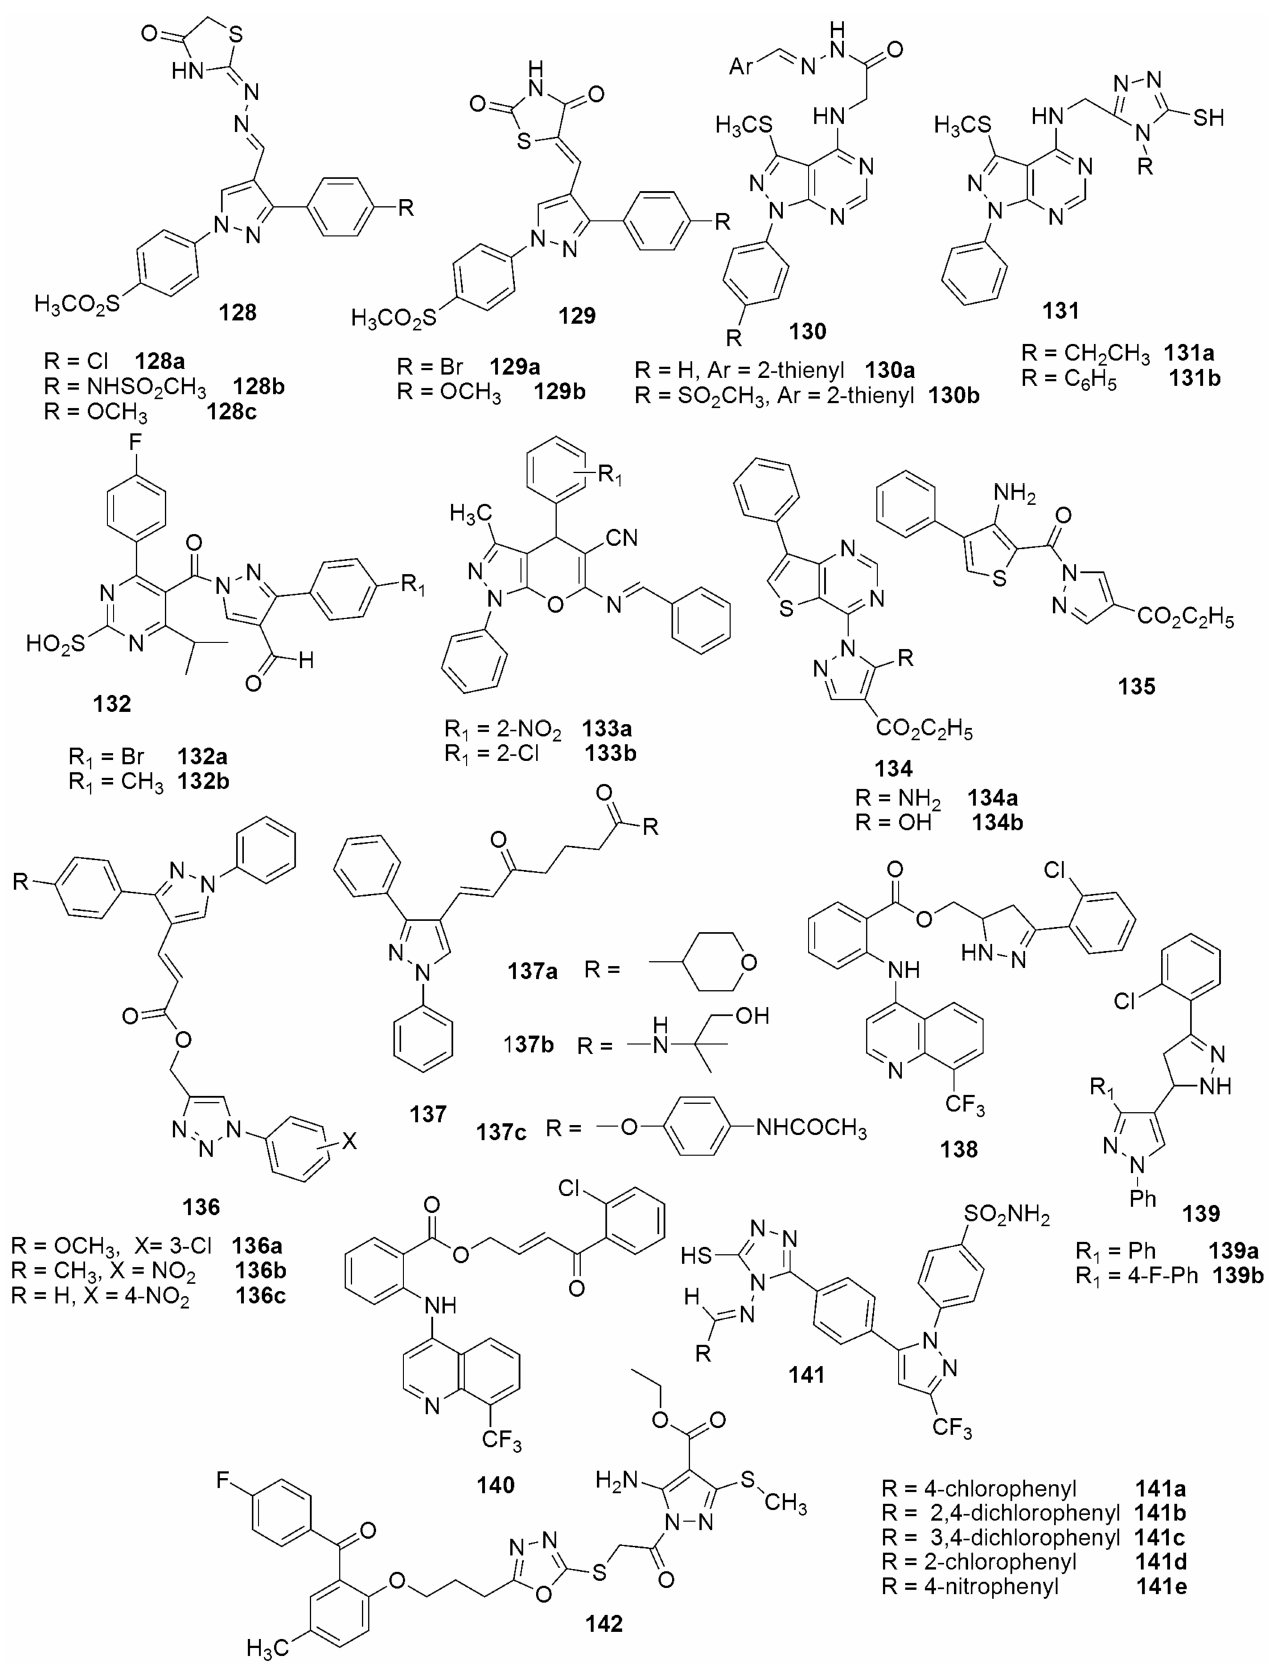
Figure 4. Structures of the pyrazole derivative with anti-inflammatory